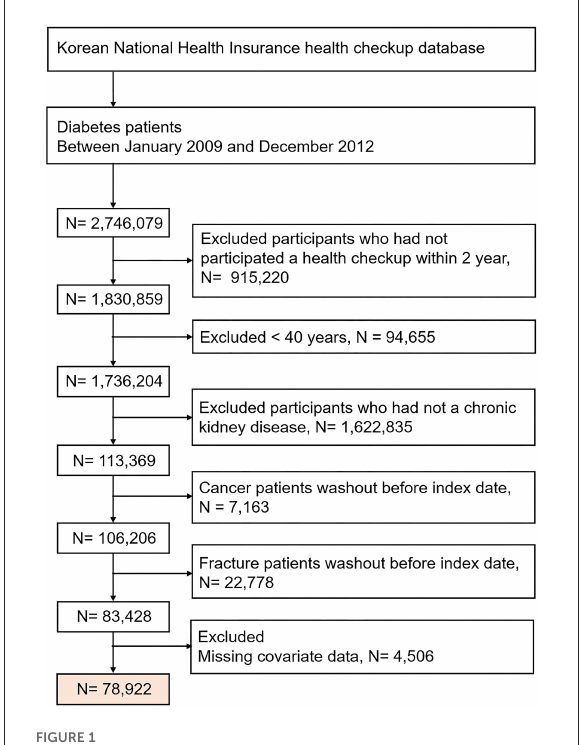
FIGURE1 Flowchart of participant